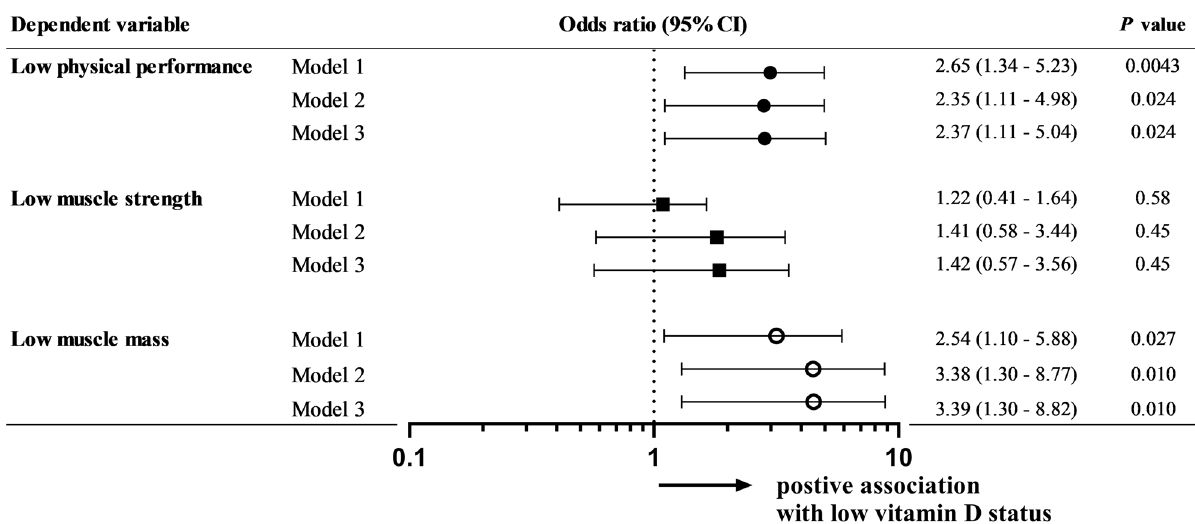
Figure 1. Associations between vitamin D status and components of sarcopenia. Results of multivariate logistic analyses for independent variables associated with components of sarcopenia. This forest plot represents the odds ratio and 95% confidence interval (CI) for each sarcopenia-related component in each adjusted model. Model 1 was adjusted for vitamin D status, age, and body mass index. Model 2 was adjusted for variables in model 1 plus nutrition status (MNA-SF) and RA-related factors (DAS28-ESR, Stage, HAQ, and therapeutics (use of prednisolone, biologics, and methotrexate)). Model 3 was adjusted for variables in model 2 plus the prevalence of osteoporosis medication.